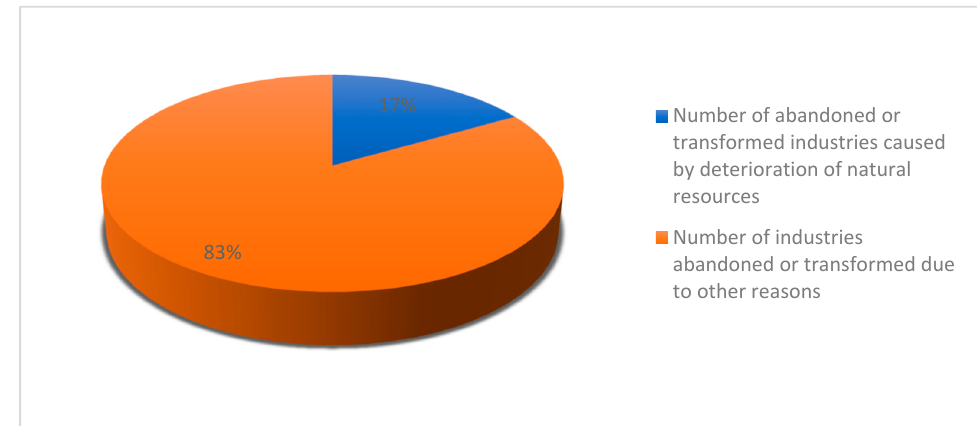
Figure 25. The relationship between the operation state of technology-intensive industries and natural resources deterioration (Figure source: own drawing; data source: on-site interview).